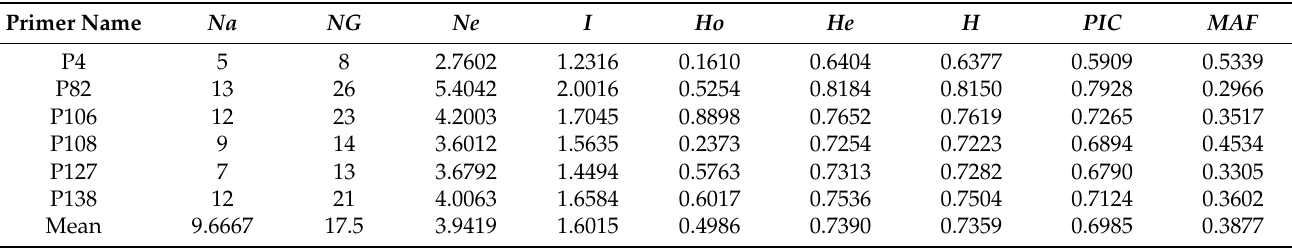
Table 2. Genetic diversity parameters of 118 Castanea plant